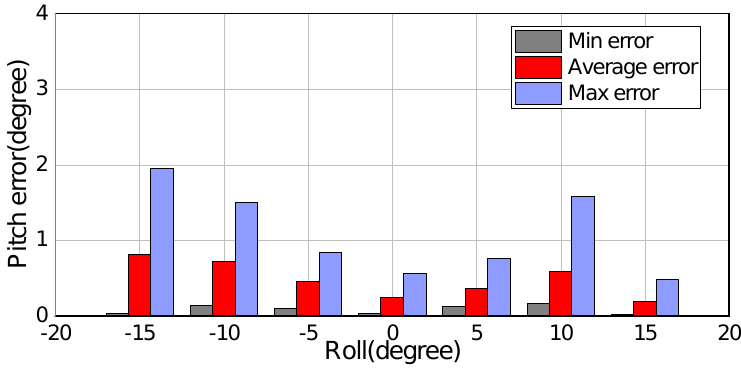
Figure 10. Errors in pitch angle at different roll